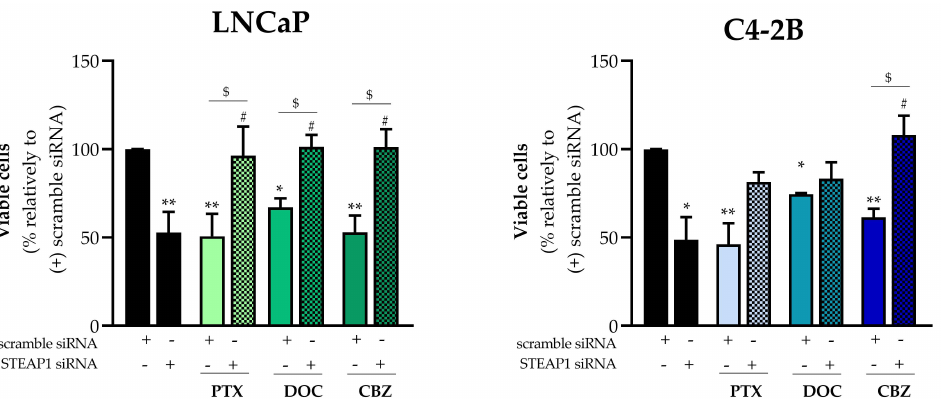
Figure 3. Effect of STEAP1 knockdown and paclitaxel, docetaxel, or cabazitaxel treatment on PCa cell viability. Human neoplastic LNCaP and C4-2B prostate cells were transfected with scramble or STEAP1 small interfering RNA (siRNA) for 24 h, and treated with 5 nM paclitaxel (PTX), 20 nM docetaxel (DOC) or 1 nM cabazitaxel (CBZ) for an additional 24 h. The symbol “+”or “-“means presence or absence of the type of siRNA used in each experimental group. The percentage of LNCaP and C4-2B viable cells was determined by MTT assay. Results are expressed as fold variation relative to the scramble siRNA group (control condition). Error bars show mean ± S.E.M (n ≥ 2). * p < 0.05 and ** p < 0.01 in comparison to the scramble siRNA group; # p < 0.05 when compared with the STEAP1 siRNA group; and $ p <